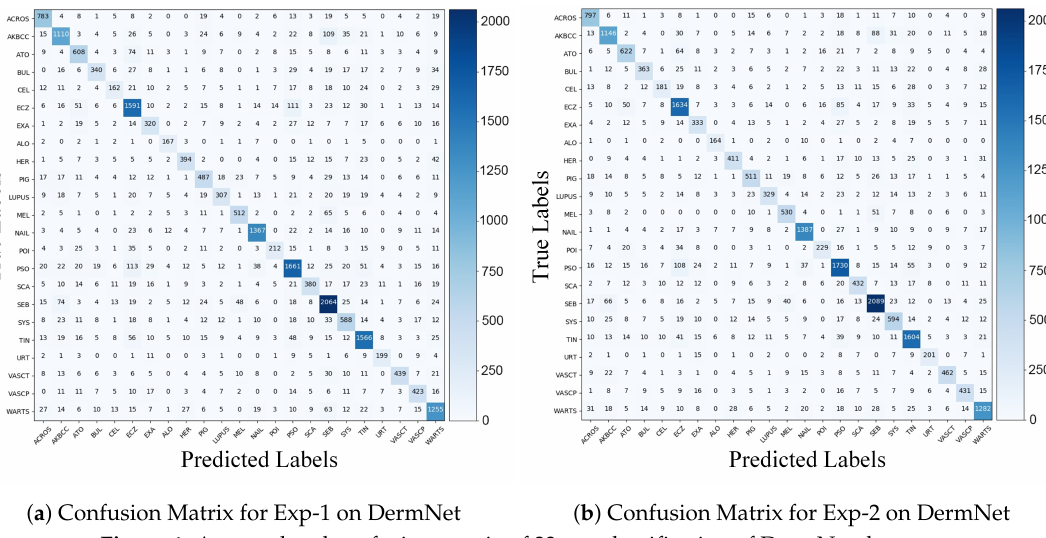
Figure 1. Accumulated confusion matrix of 23-ary classification of DermNet dataset.